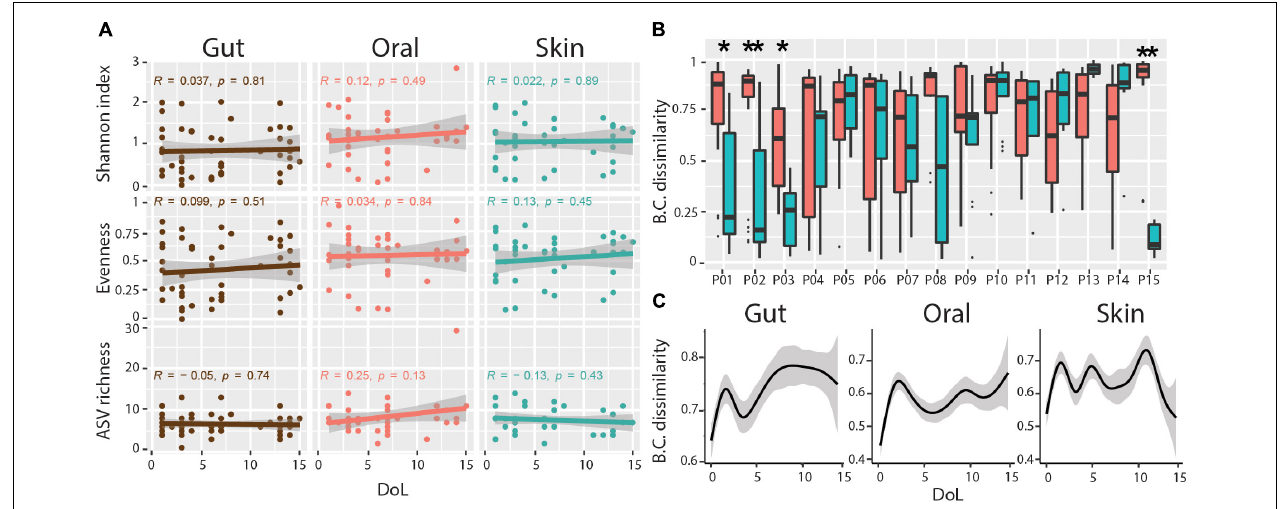
FIGURE 2 | Diversity and body-site-specificity of microbiomes. (A) Alpha diversity metrics over patient days of life. Linear regression Pearson r and p -values are shown within each subplot. (B) Bray-Curtis (BC) dissimilarities of samples from the same body site compared to samples across body sites for each infant. Wilcoxon Rank-sum test, adjusted p -values * < 0.01, ** < 0.001. (C) Progression of Bray-Curtis (BC) dissimilarities ( Y -axis) in ELBWI with increasing distance over time ( X -axis). Smoothed lines result from locally estimated scatterplot smoothing (LOESS) and indicate trends of